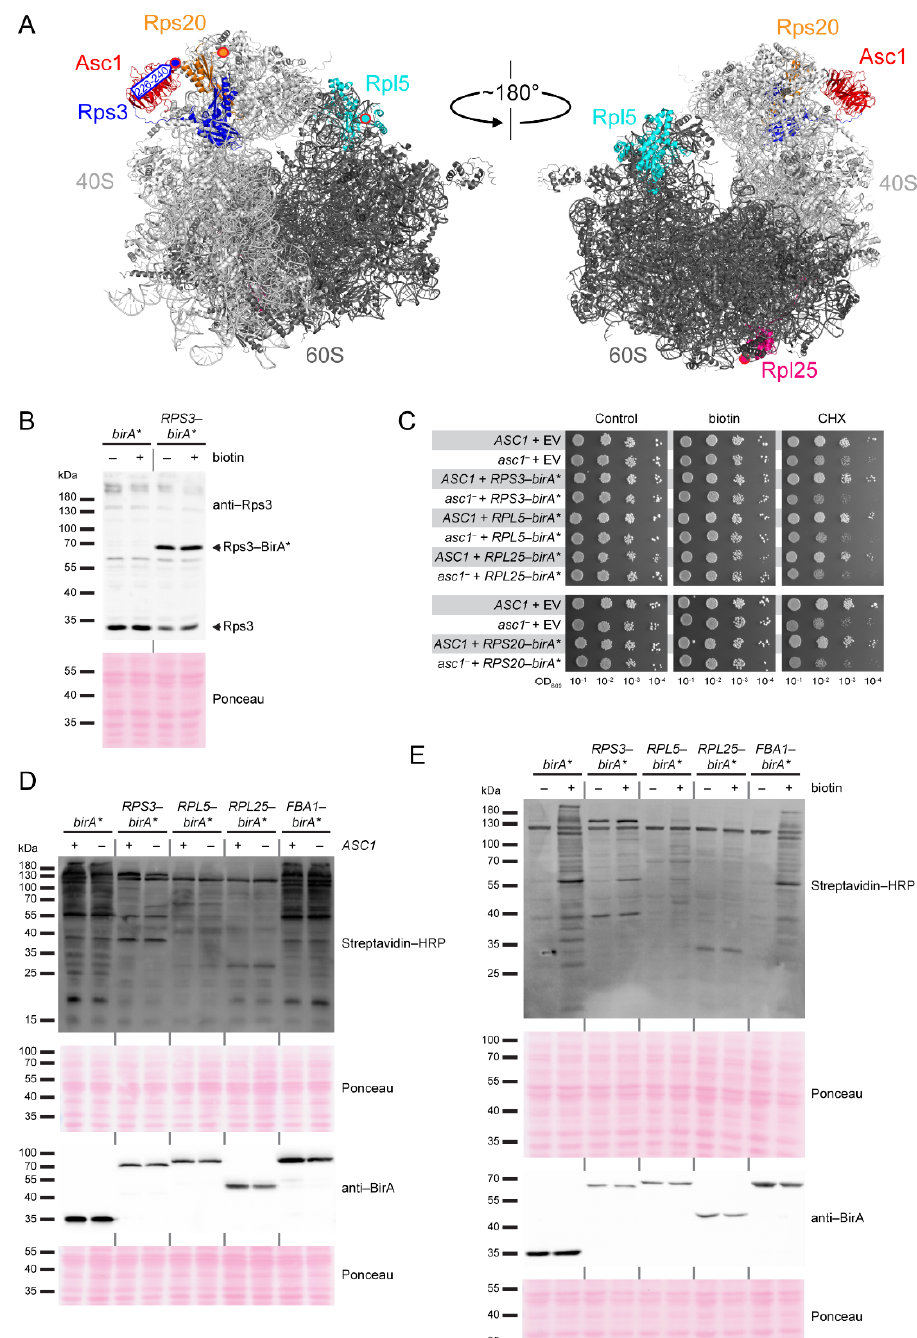
Figure 1. BirA* fusion protein expression and monitoring of biotinylation activity. ( A ) Structure of the S. cerevisiae 80S ribosome with Asc1 (red), Rps3 (blue), Rps20 (orange), Rpl5 (cyan), and Rpl25 (pink) highlighted. rRNA and proteins of the 40S subunit are colored in light gray and rRNA and proteins of the 60S subunit in dark gray. Since the proteins of interest were C-terminally fused to BirA*, the (approximate) position of each C-terminus is indicated with a red-rimmed circle filled with the respective color. For Rps3, the C-terminal amino acids R226-A240, which are structurally not resolved, are indicated with an arrow. Crystal structure data from PDB entry 4V88 [4] were visualized using the PyMOL molecular graphics system. ( B ) Protein extracts of ASC1 wild-type cells expressing either free BirA* or Rps3-BirA* were separated by SDS polyacrylamide gel electrophoresis (PAGE) and proteins were blotted onto a nitrocellulose membrane. An Rps3-specific antibody [3] was used to detect native endogenous Rps3 and the Rps3-BirA* fusion protein. Respective signals are labeled and highlighted with an arrow. Strains were cultivated in the presence and absence of 10 µ M biotin. ( C ) The growth of ASC1 wild-type and asc1 − strains (RH2817 and RH3510, respectively) expressing RP-BirA* fusion proteins was